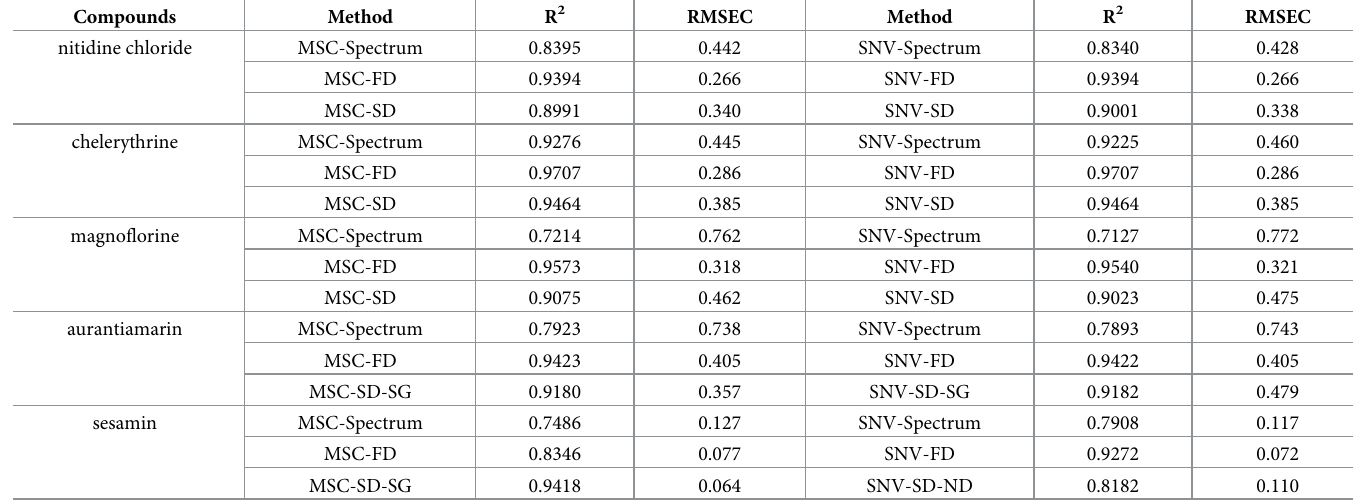
MSC, multiplicative scatter correction; SNV, standard normal variate; FD, first derivative; SD, second derivative; SG, Savitzky Golay smoothing with a polynomial order of 3 fitted over a 5-nm